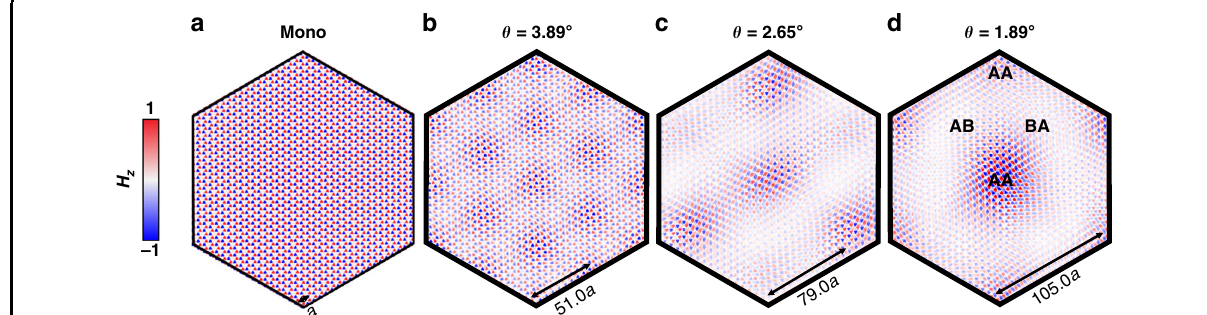
Fig. 3 Mode localization in the twisted bilayer photonic crystals. a For monolayer photonic crystal slab, the quasi-TE modes at the K points are itinerant and persist across the entire supercell. b , c At large angle like 3.89° and 2.65°, the quasi-TE modes become localized on the AA-stacked region in the center of the supercell as θ decreases. d The quasi-TE modes are mostly localized when θ ¼ 1 : 89